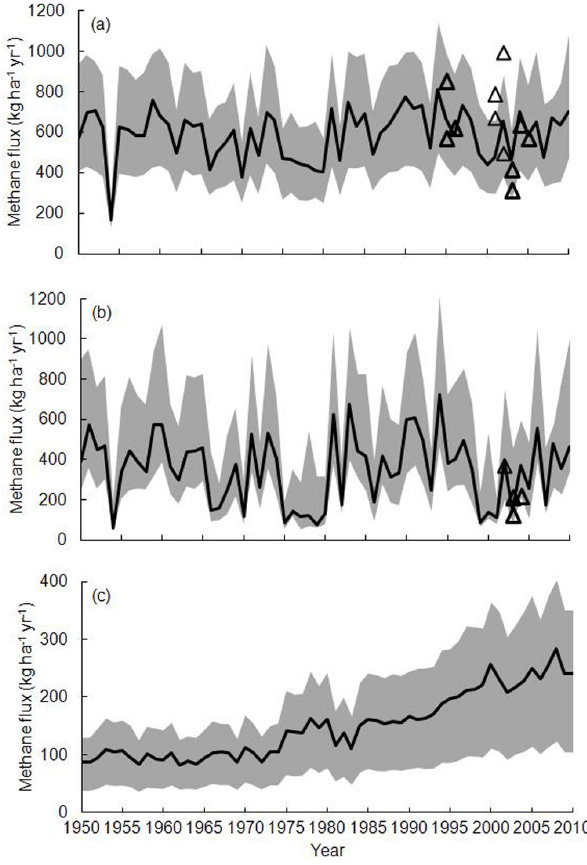
Fig. 4. Variations in the area-weighted air temperature (a) , precip- itation (b) and net radiation (c) on the Sanjiang Plain from 1950 to 2009. Solid lines represent the interannual variations; the trian- gles represent the interdecadal variations, and the vertical bars are standard deviations of 10yr of each